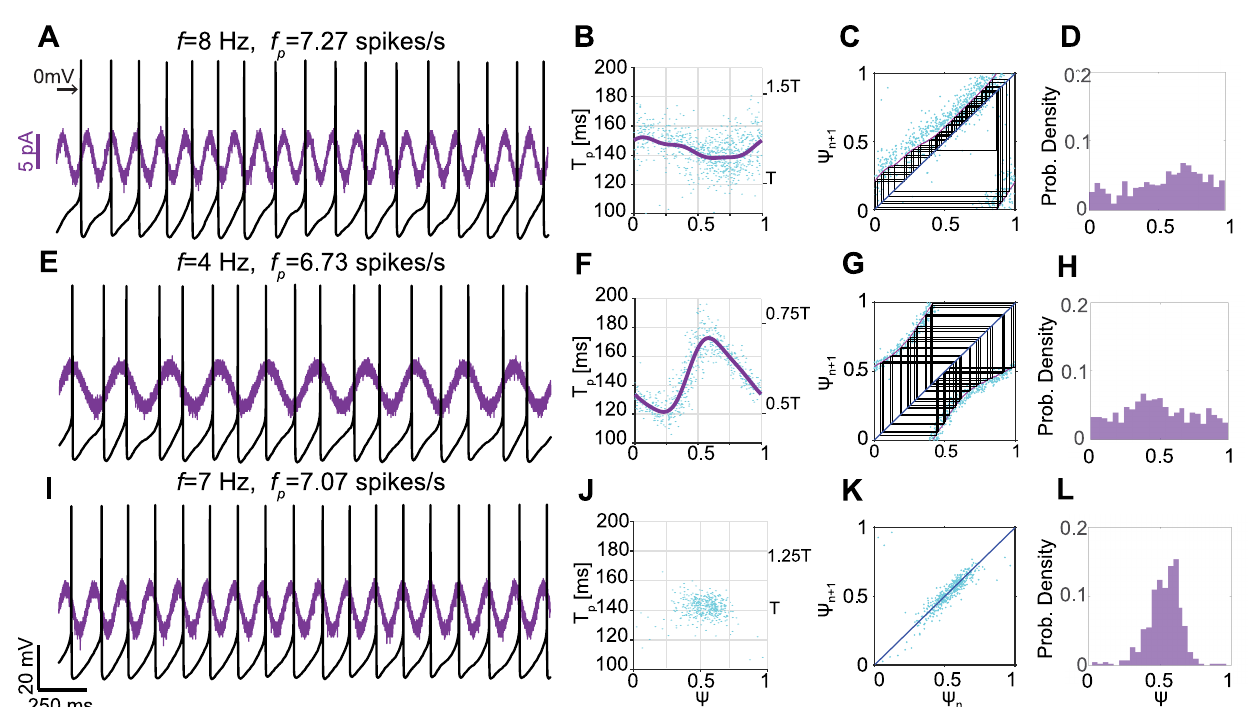
Fig 5. Entrainment of the spiking of SNr GABAergic pacemakers using sinusoidal somatic current injection. A: Perforated patch recording of a spontaneously firing cell with an average perturbed firing rate f p , as a cosine shaped current of frequency f was injected into the soma. When f is sufficiently larger than the natural firing rate f , the pacemaker’s firing is not phase-locked to the periodic input. Left arrow indicates 0 mV. B: Scatter plot of the 0 perturbed period of the cell’s spiking T p as a function of the effective phase ψ in which the spike occurred (cyan). Fitted curve (purple) was used to generate the iterative map shown in C. Right-hand-side y-scale shows T p in units of T , the period of the rhythmic stimulus. C: An iterative map of the effective phase versus that of the current spike ψ (purple). Dots represent empirical data, and the map is generated from the fitted curve in B. The of the next spike ψ n+1 n map is mostly above the diagonal and does not transect it (blue). Cobweb plot (black) uncovers chaotic dynamics. D: The distribution of effective phases is broad and samples the entire range between 0 and 1. E, F: Same as A, B with f < f . G: Same as C with f < f . The map (purple) is mostly below the diagonal 0 0 (blue) and does not transect it. H: Same as D with f < f 0 . I: When f~f 0 , the cell’s spiking is phase-locked to the oscillatory input. The spike tends to occur at or slightly after the peak of the stimulus. J: Due to phase locking, the cell visits a narrow range of effective phases. All points of the perturbed period versus the effective phase are gathered around phase 0.6. The period of the cell’s spiking is approximately constant and equal to the period of the stimulus T . K: All phase points are located on the diagonal and around phase 0.5, indicating phase locking. Therefore, a map cannot be estimated. L: The distribution of effective phases shows a clear peak around the phase of entrainment (~0.6).